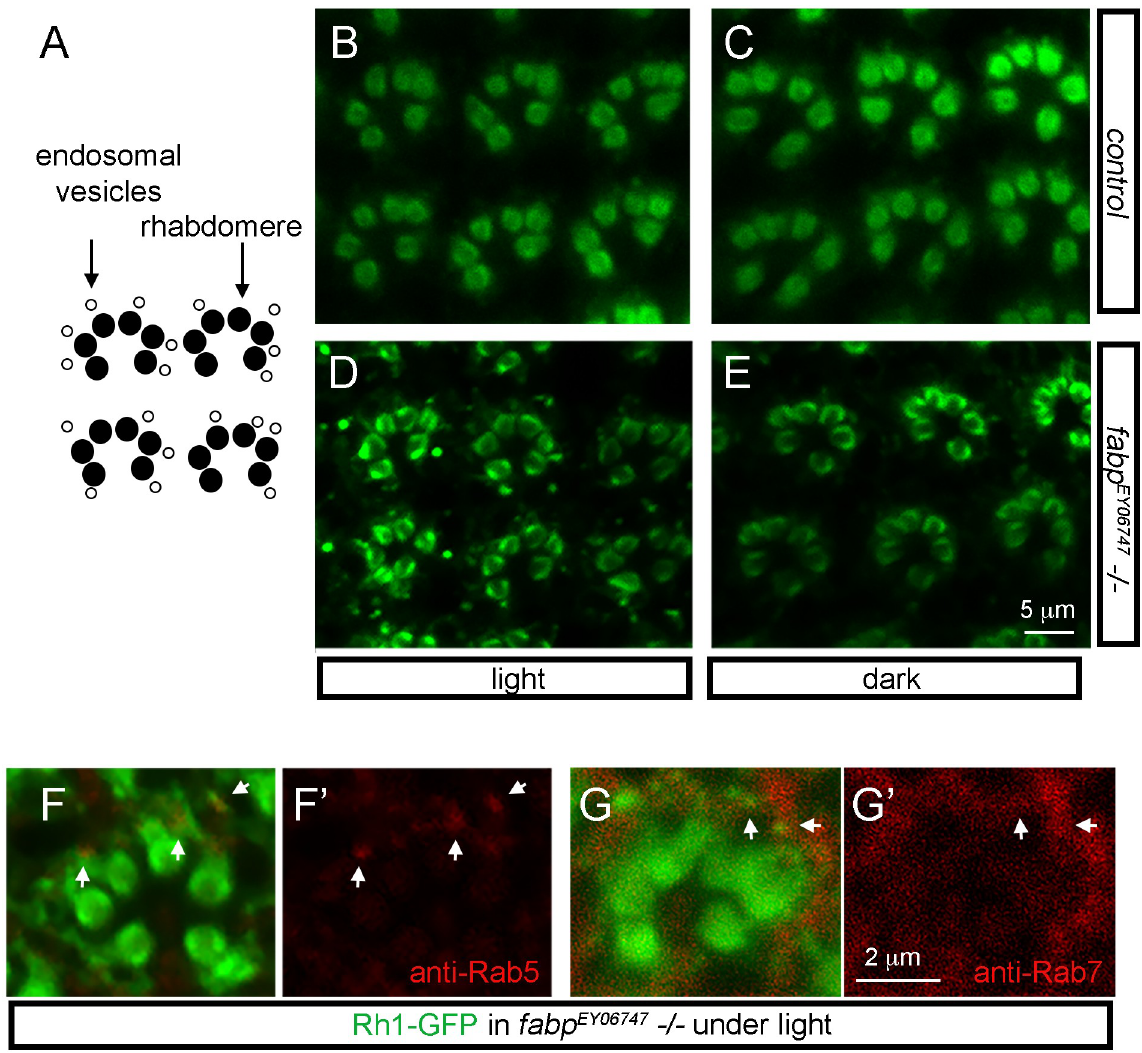
Fig 6. Rh1 protein localization in fabp EY06747 mutant eyes. (A) A schematic diagram of adult Drosophila ommatidia, with rhabdomeres labeled as black circles, and endosomal vesicles as white circles. (B-E) Anti-Rh1 labeling (green) of adult Drosophila ommatidia. (B, C) Control fabp wild type eyes. (D, E) fabp EY02678 -/- eyes. Fly samples (B, D) were reared under constant light before being processed for fixation and immuno-labeling. By contrast, samples (C, E) were reared under constant darkness before processing. The scale bar in G applies for images D– G. (F, G) Assessment of Rh1 localization in fabp EY06747 -/- flies reared under light through ninaE-GFP expression (green). This line has GFP fused in frame with the Rh1 protein sequence, driven by the ninaE promoter. Rh1-GFP is found in rhabdomeres and in cytoplasmic puncta. (F) Double labeling with anti-Rab5 antibody that marks early endosomes (red). (G) Double labeling with anti-Rab7 antibody that marks late endosome/lysosomes (red). Single channel images of the red channel are in (F’, G’). White arrows point to representative regions of overlap. The scale bar in K’ represents images in J and